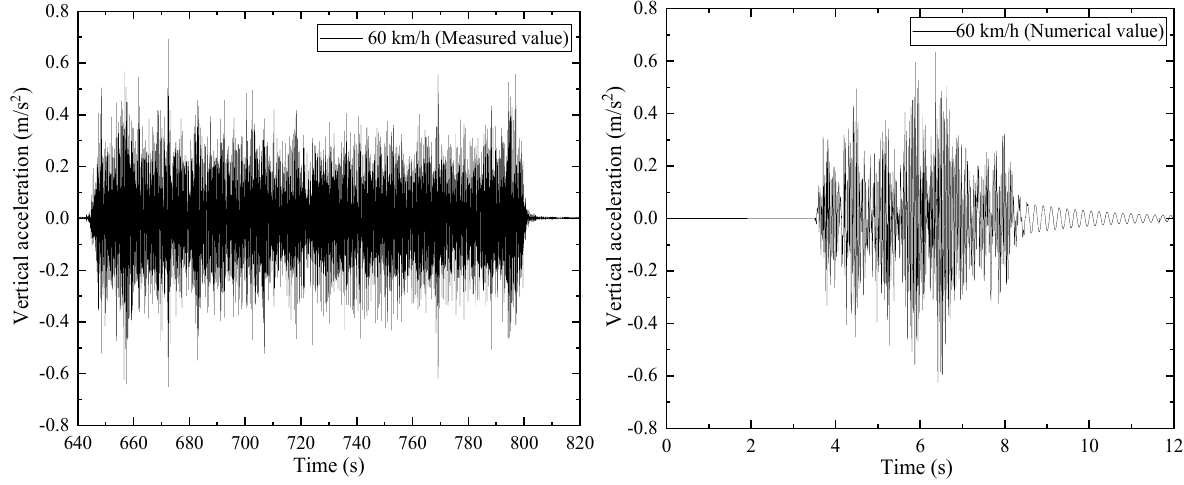
Figure 19. The midspan vertical acceleration time-history response of the beam. The wheel-rail force time-history curves under different axle weights and operating speeds can be obtained through the vehicle-bridge coupling simulation calculation. Taking the second wheelset of the front bogie of the first train as an example, the vertical time-history force of wheel-rail is shown in Figure 20, when the train with 25 t axle weight passed through 32 m standard height prestressed concrete beam at speeds of 40 km/h and 60 km/h. Through the analysis step (4) in Section 3.1, the calculated stress amplitudes values of tensile reinforcement in the prestressed concrete beam were 45.93 MPa, 51.44 MPa, 55.11 MPa, and 60.62 MPa, when the train axle weights were 25 t, 28 t, 30 t, and 33 t, respectively. This can be used to determine the load of fatigue test analysis.